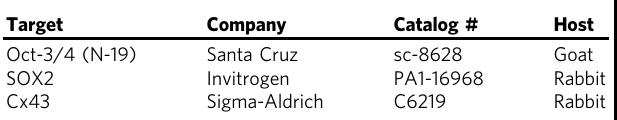
Table 1 List of antibodies and their respective catalog numbers Target